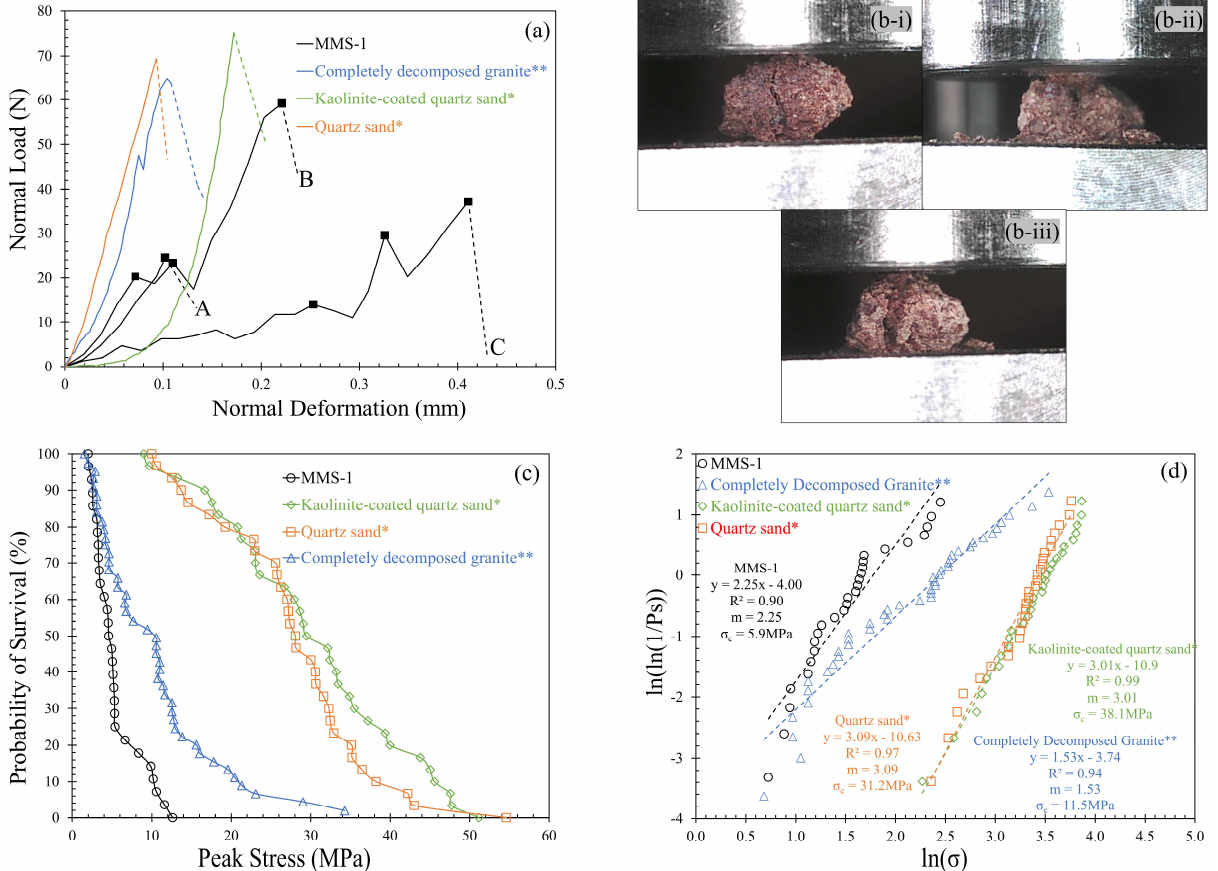
Figure 4. ( a ) Variation of normal load against normal deformation; ( b ) Modes of crushing observed for MMS-1: ( b-i )- Splitting, ( b-ii )-Significant fragmentation, ( b-iii )-Mixed; ( c ) Variation of survival probability with peak stress; ( d ) Determination of Weibull modulus and characteristic strength. (* Kasyap and Senetakis [81]; ** Wang and Coop [80]).